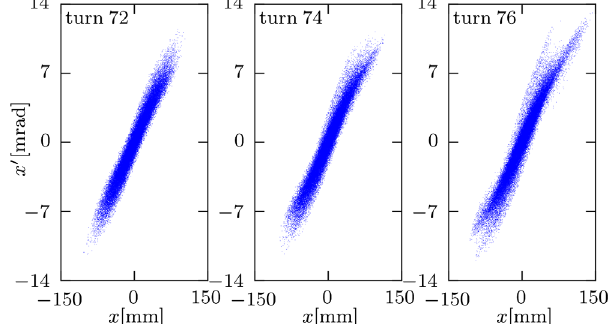
FIG. 15. Evolution of the particle distribution in the x − x 0 phase space at final stage of bunch compression with k 0 104 ° at 72th, 74th, 76th turns during bunch compression. k 0 ;y ¼